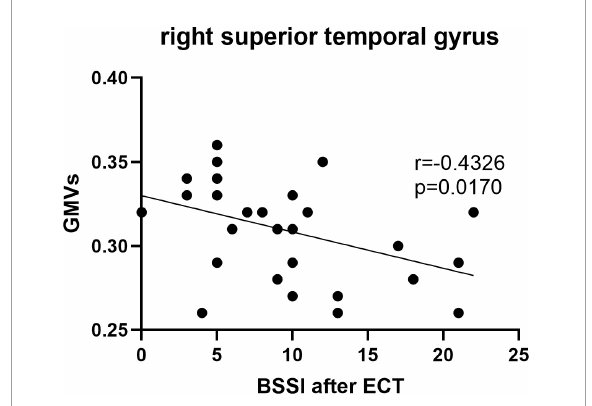
FIGURE7 Negative correlations between the BSSI after ECT and GMVs in the right superior temporal gyrus ( r = –0.4326, p =